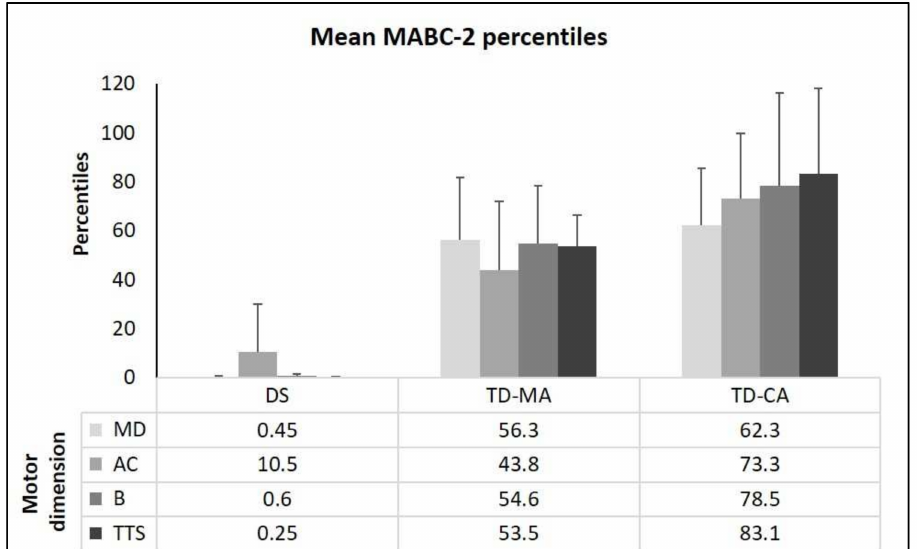
Figure 1. Movement Assessment Battery for Children-2 percentiles (mean + standard deviations) for the three sub-tests (MD: manual dexterity; AC: aiming and catching; and B: static and dynamic balance) and mean total test score (TTS) percentiles. Note: DS = Down Syndrome; TD-MA = Typically developing children of the same mental age; TD-CA = typically developing children of the same chronological age.